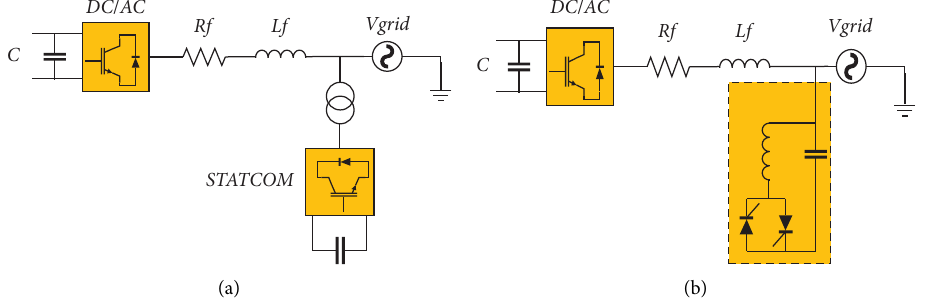
Figure 9: Te connection of STATCOM (a) and SVC (b) to the PCC.